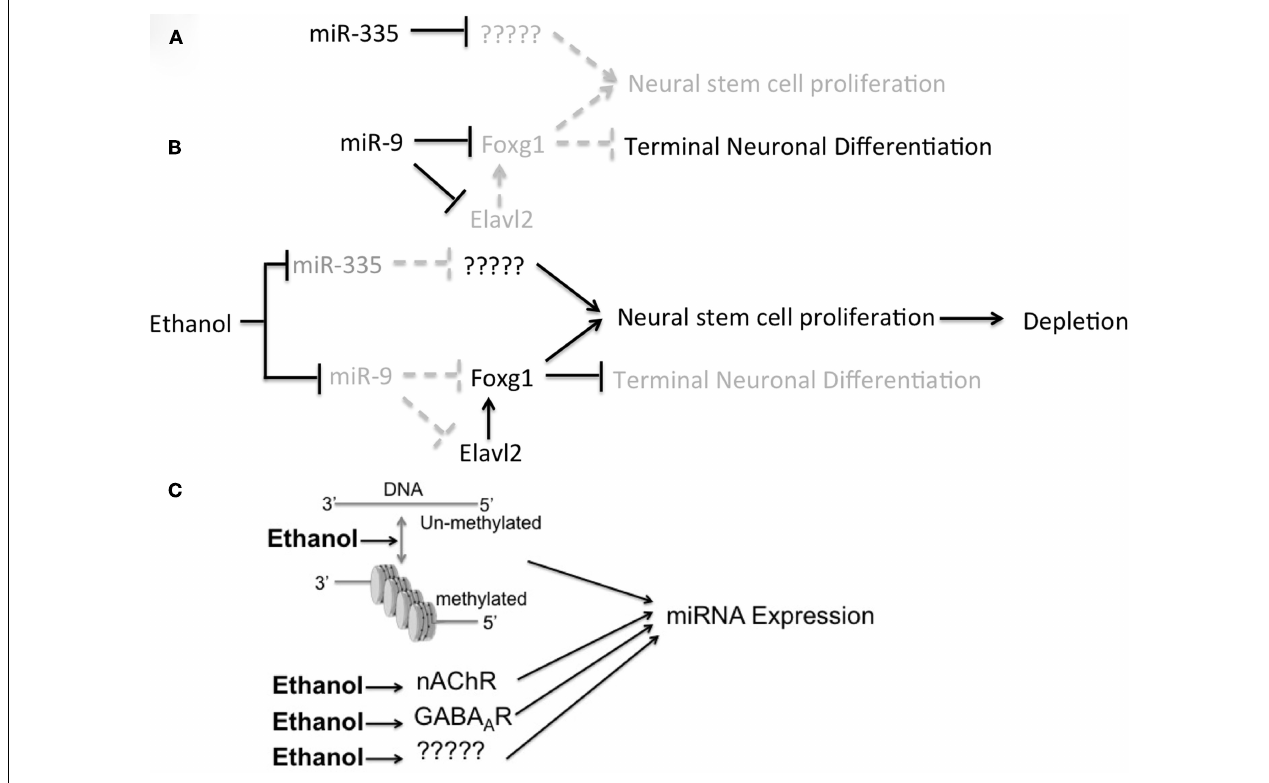
aberrant NSC proliferation, ultimately depleting the NSC pool. (C) The collective data supports two mechanisms for ethanol control of miRNAs, i.e., by regulating the epigenetic landscape of the genome and by influencing the activity of ligand-gated ion channels like nicotinic acetylcholine receptors (nAChRs) and GABA A receptors (GABA A